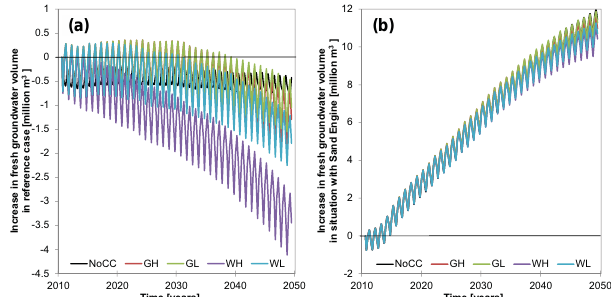
Figure 10. Increase of the volume of fresh groundwater in the sit- uation without Sand Engine (a) and situation with Sand Engine (b) in the period 2011 to 2050, where the legend refers to (climate) sce- narios (as mentioned in Table